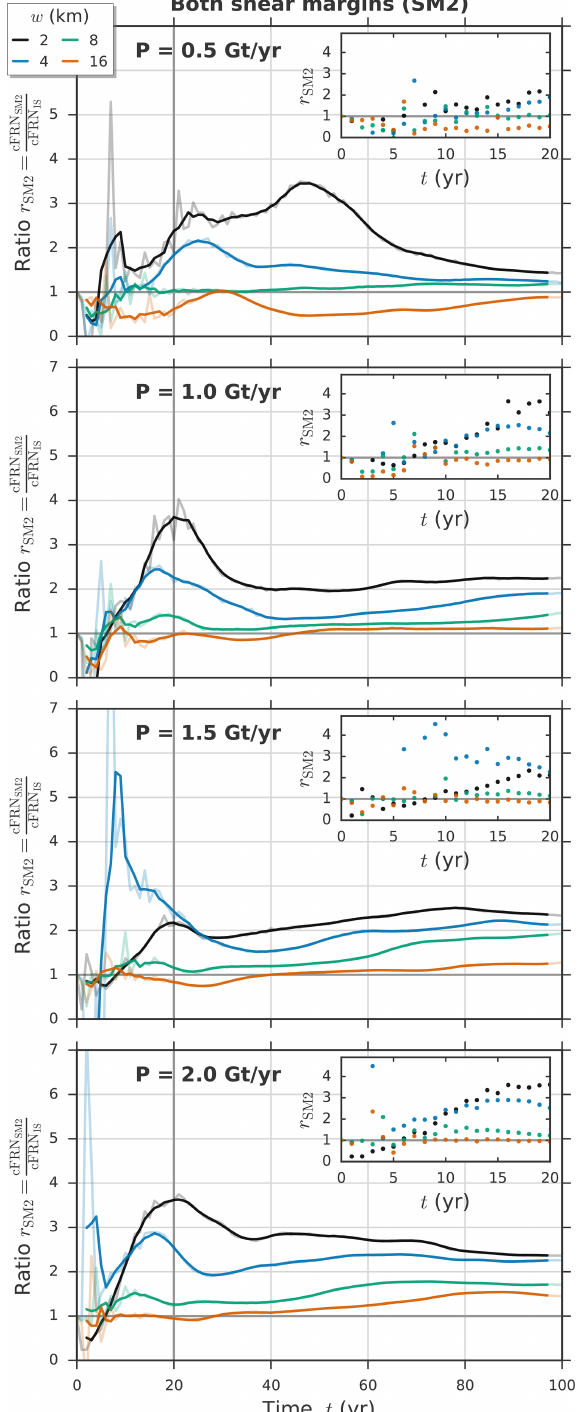
Figure 7. Time evolution of the cFRN ratio r SM2 for the four pertur- bation strengths P and the four melt strip widths w (colors given in the legend). The curves show the 5-year running mean of the yearly data (light colors). For each panel the yearly data points for the first 20 model years are shown in the corresponding inset. A comparison to the qualitatively very similar curves of r SM1 is given in Fig.